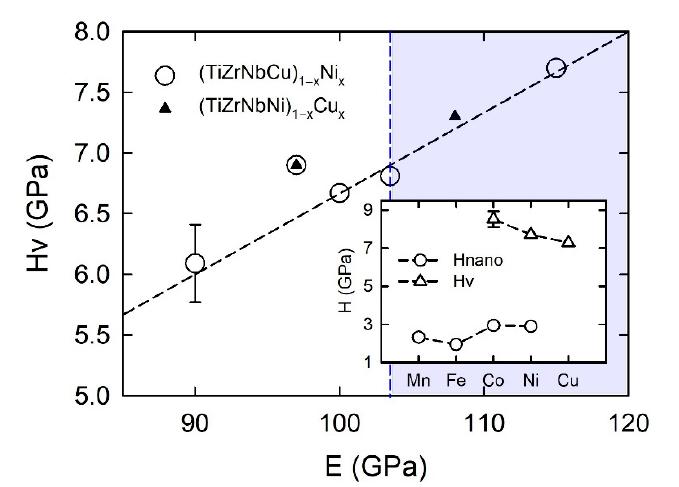
Figure 19. A plot of H V vs. E for (TiZrNbNi) 1 − x Cu x and (TiZrNbCu) 1 − x Ni x MGs. The inset: H V of MGs with x = 0.43 and H nano for Cantor-type alloys with x = 0.5 Mn, Fe, Co and Ni. The dashed line in Figure 18 illustrates the variation of H nano of single-phase (CrM- nCoNi) 1 − x Fe x FCC alloys with x [47]. As expected, for crystalline alloys, due to crystal slip